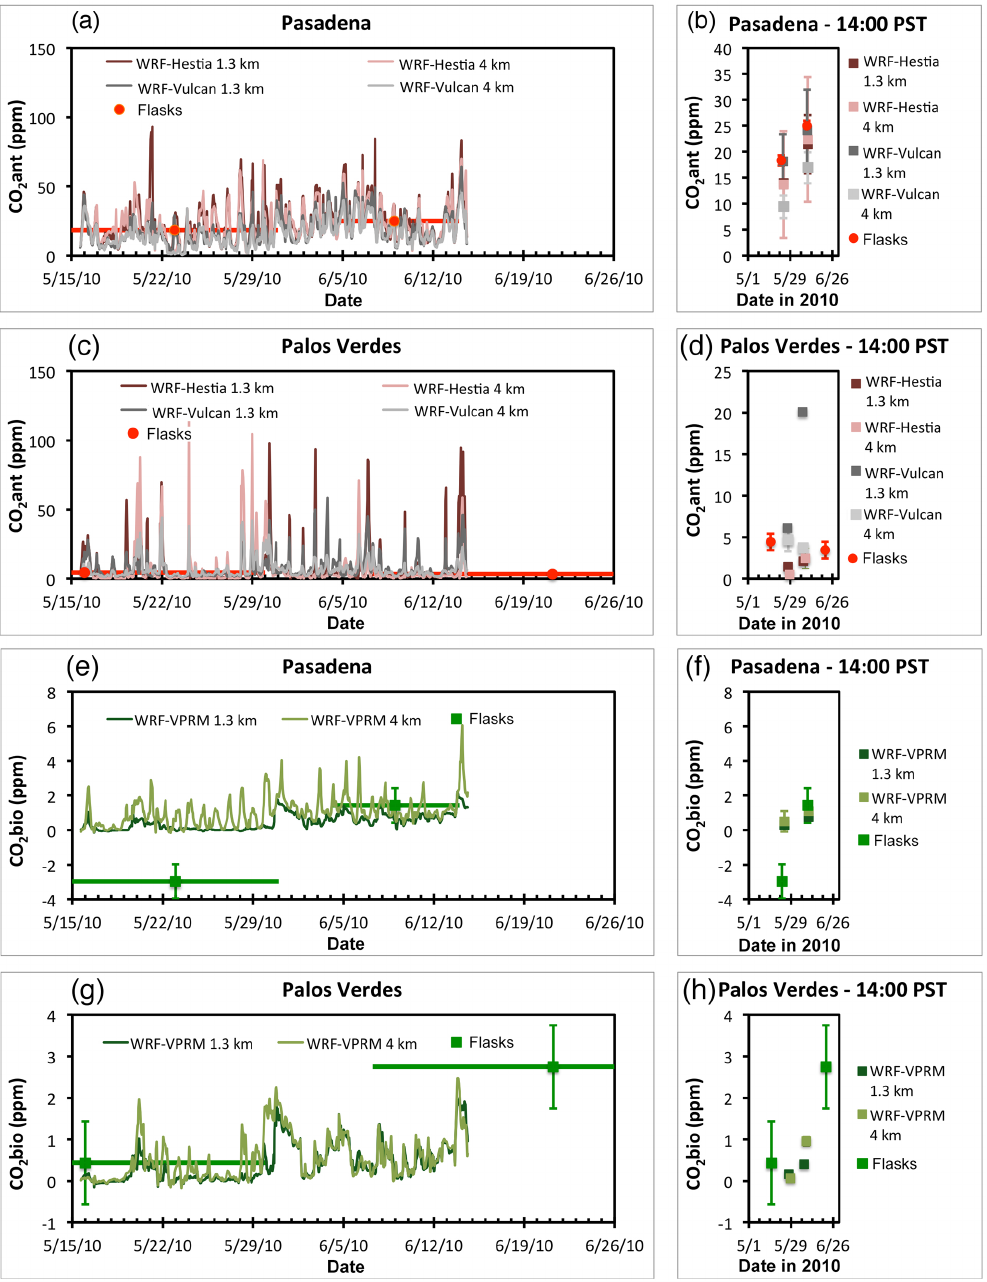
Figure 10. Comparisons of flask-sampled and modelled (a–d) anthropogenic fossil fuel and (e–h) biogenic CO 2 concentration. Left column: hourly time series. The horizontal error bars on the flask-sampled data points indicate the range of dates combined in each sample. Note that much of the time period for the (cid:49) 14 C samples at the Palos Verdes site is before or after our modelling period. Right column: averages at 14:00PST during CalNex-LA. See Newman et al. (2016) for details about the sites and sampling